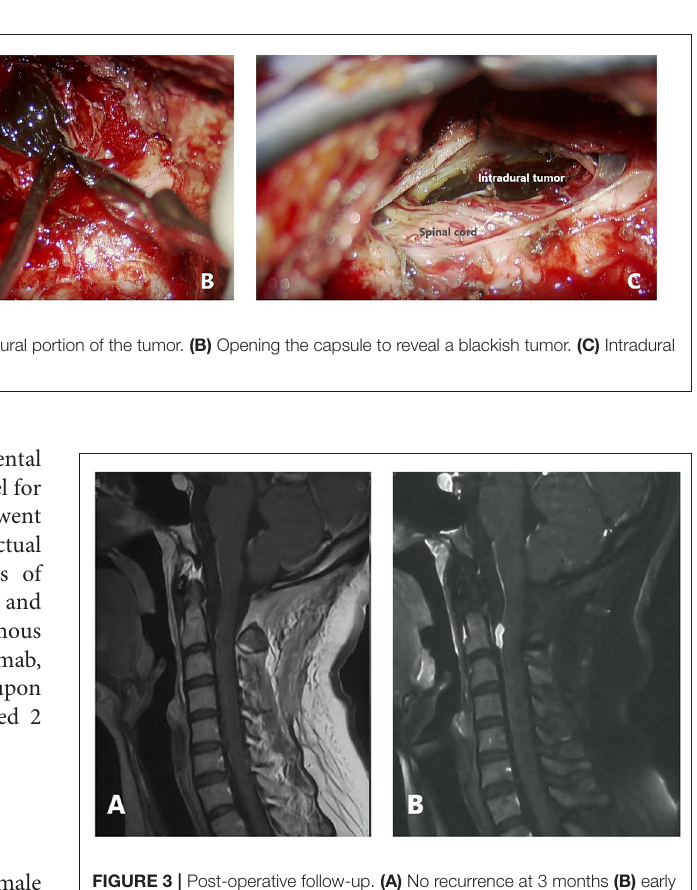
FIGURE 3 | Post-operative follow-up. (A) No recurrence at 3 months (B) early local recurrence at 6